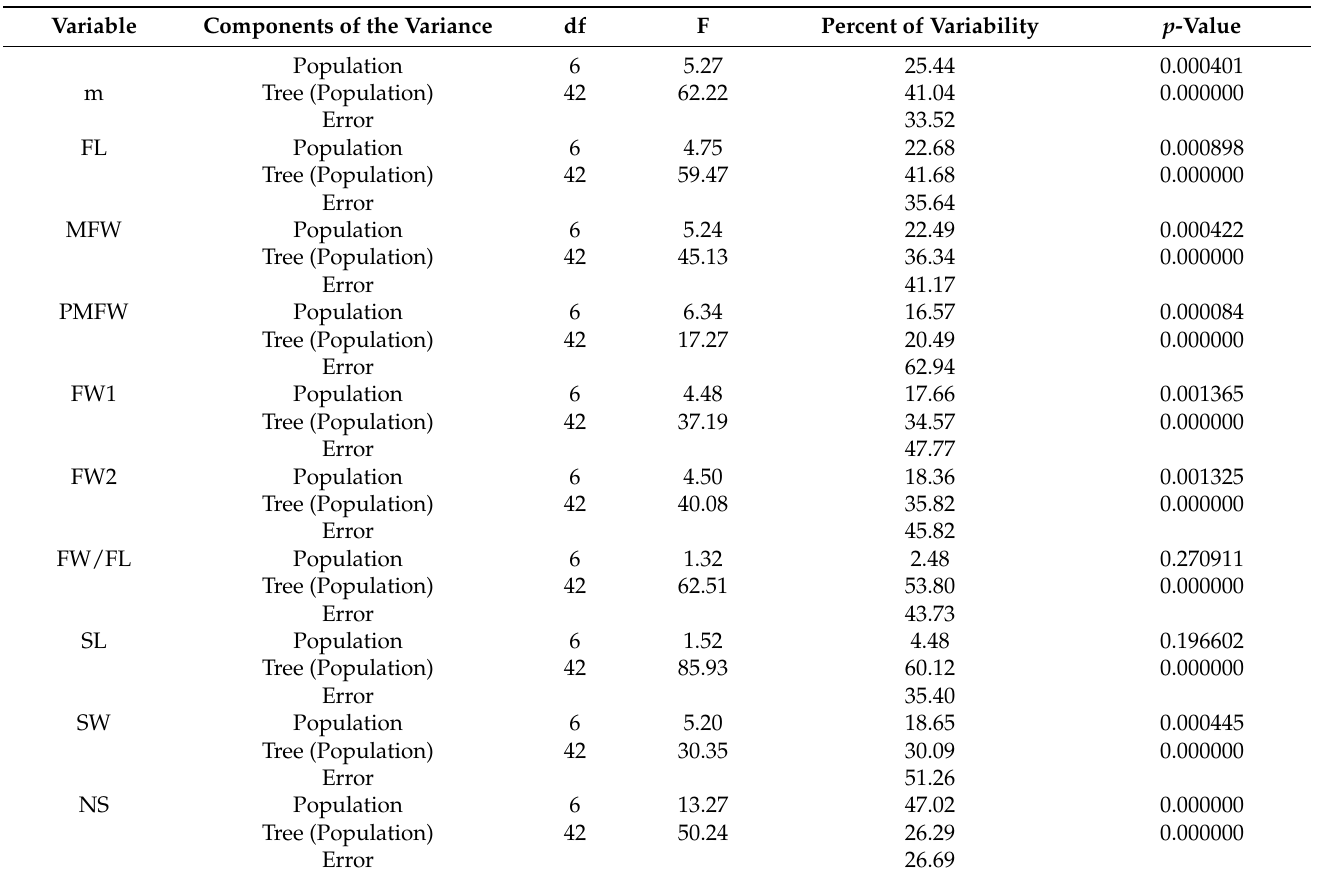
Table 2. Results of the hierarchical analysis of variance for fruit and seed morphometric characteristics. Acronyms for fruit and seed morphometric characteristics as in Table